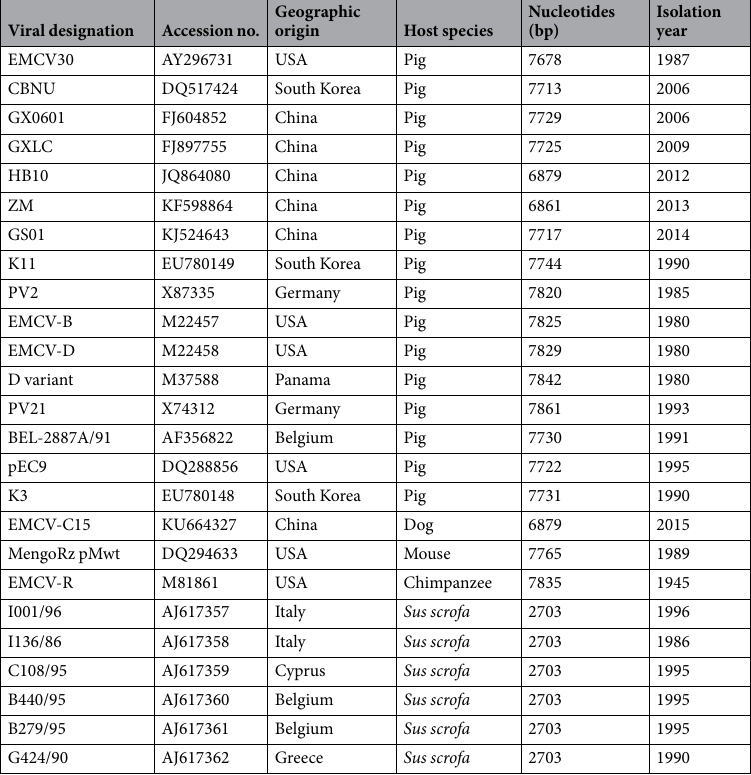
Table 3. Encephalomyocarditis virus isolates used in this study. Multiple sequence alignment based on ORFs and other strains available from the GenBank nucleotide database was completed using the Clustal X